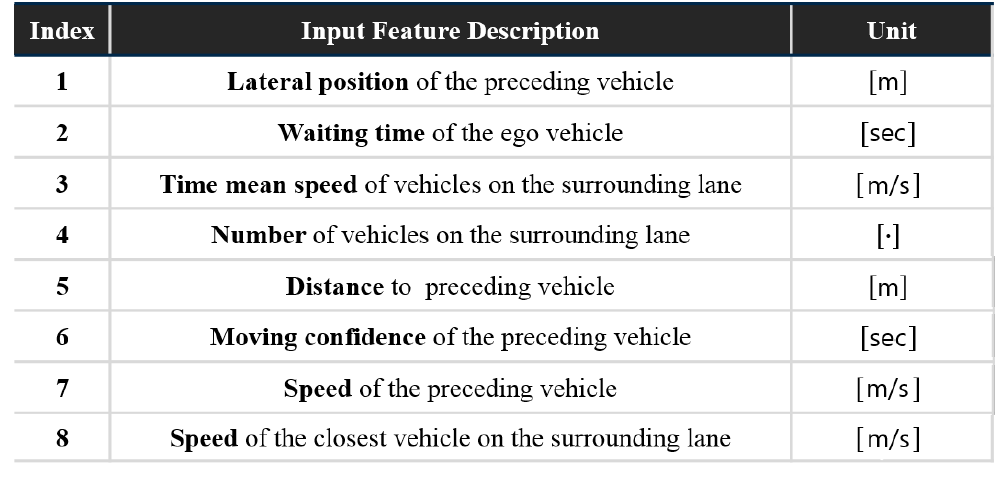
Figure 9. Input factors of the model.